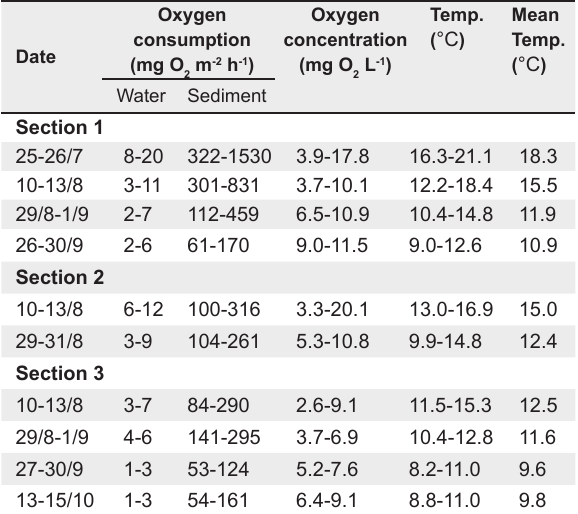
Table 2. Minimum and maximum values of the in situ oxygen consumption, oxygen concentration and